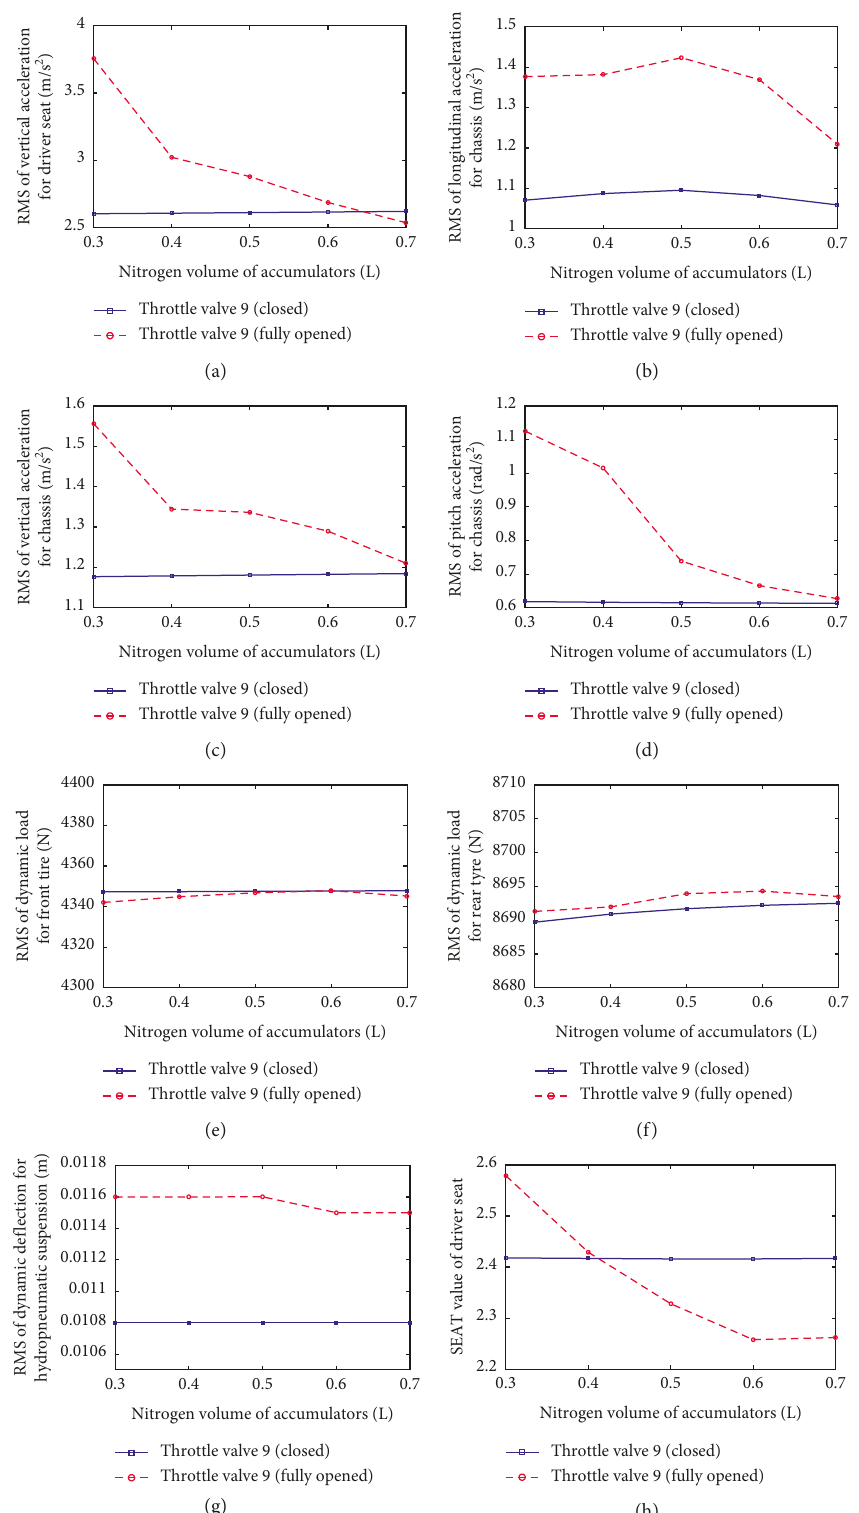
Figure 13: RMS of vibration responses of the tractor system under different initial nitrogen volumes of accumulators: (a) vertical ac- celeration of the driver seat; (b) longitudinal acceleration of the chassis; (c) vertical acceleration of the chassis; (d) pitch acceleration of the chassis; (e) dynamic load of the front tire; (f) dynamic load of the rear tire; (g) dynamic deflection of the hydropneumatic suspension; (h) SEAT value of the driver